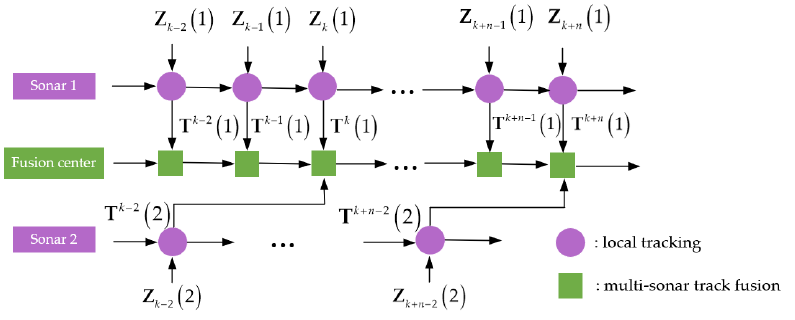
Figure 1. Multi-sonar OOSTs fusion framework.